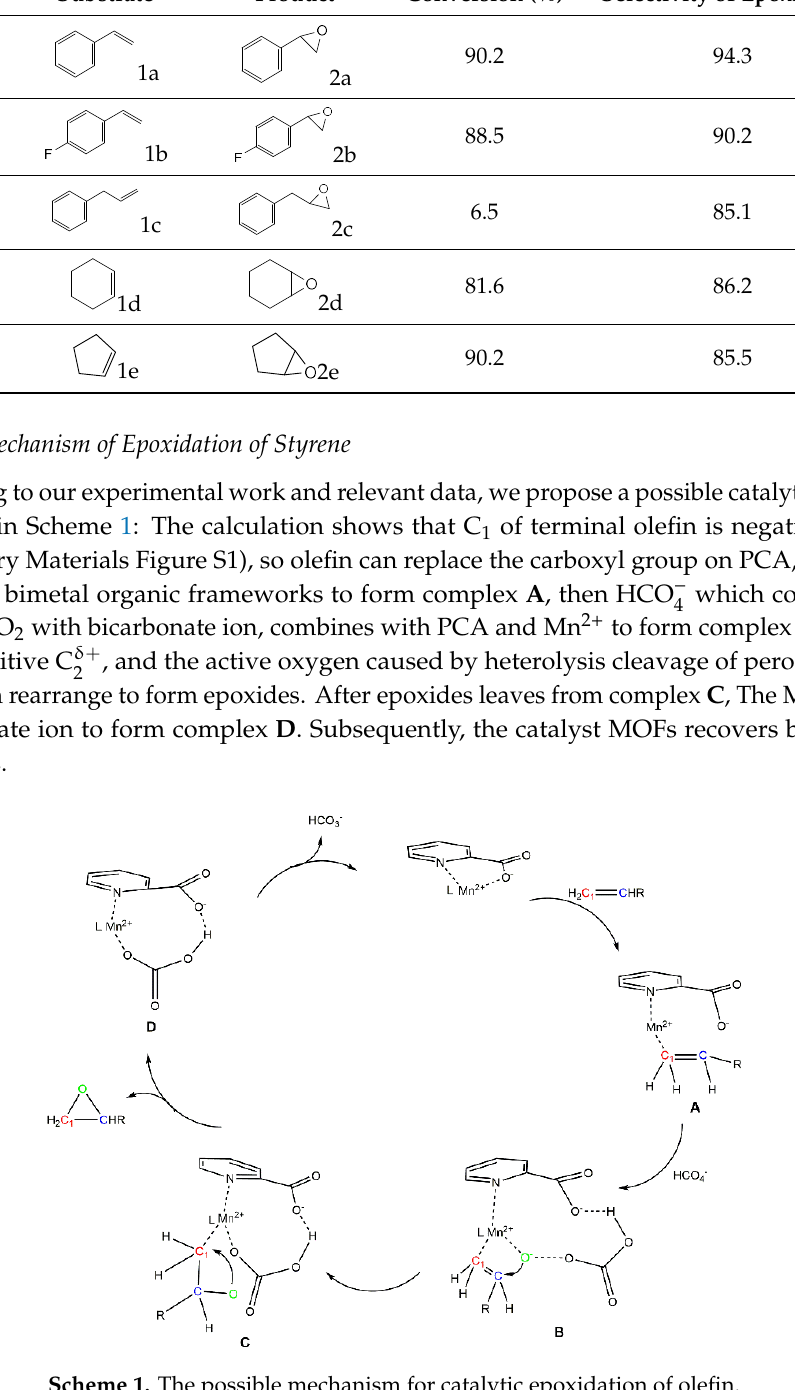
Figure 8. Recycle experiments of styrene epoxidation with Mn 0.1 Cu 0.9 -MOF. 2.9. Decomposition of H 2 O 2 H 2 O 2 is usually stable in neutral solution. However, metal ion and metal complex can promote the decomposition of H 2 O 2 [29]. Here we investigated the influence of the prepared MOFs on decomposition of H 2 O 2 , as illustrated in Figure 9. From Figure 9 it can be seen that the Cu-MOF and Mn 0.1 Cu 0.9 -MOF displayed weak activity for the decomposition of H 2 O 2 . The decompositions of H 2 O 2 catalyzed by Cu-MOF and Mn 0.1 Cu 0.9 -MOF were 3.1% and 4.0% after reacting 6 h, respectively, at 0 °C.